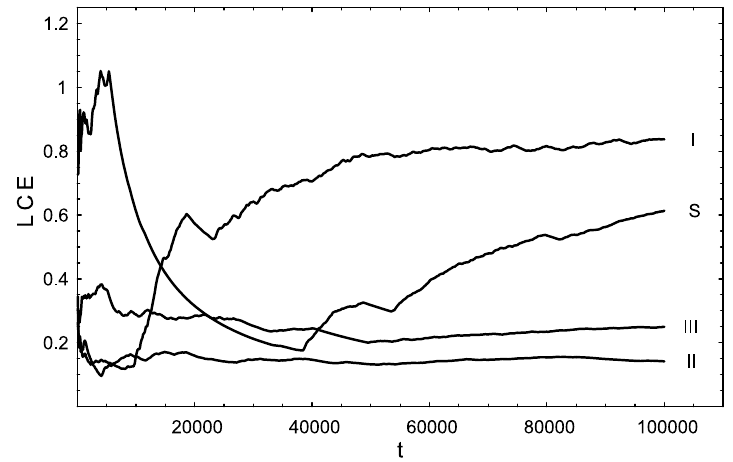
Fig. 5. The LCEs for the three different chaotic components I, II, III and the chaotic sea S. 0.1423 and for the chaotic component III the value 0.2512. The LCE value for the chaotic sea is 0.6137.